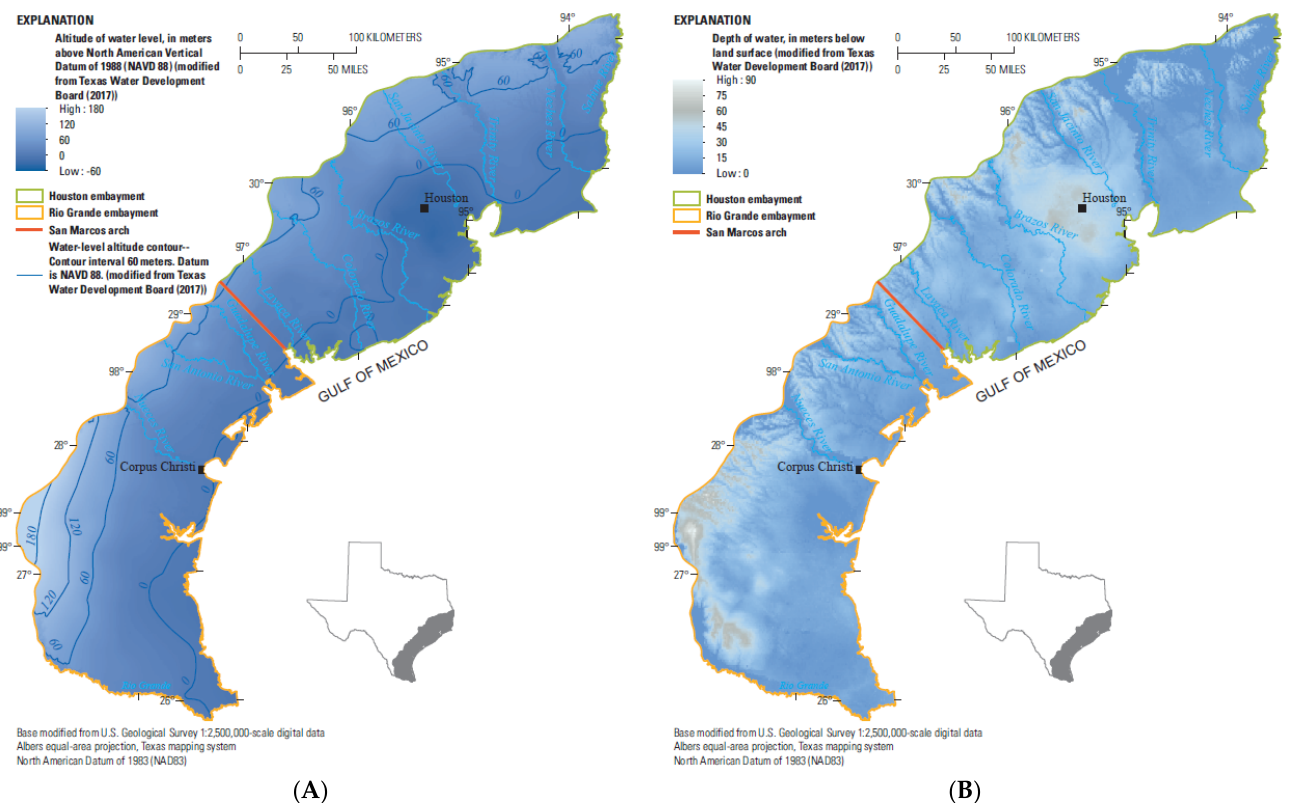
Figure 10. Recent (2007–2016) ( A ) water-level altitudes and ( B ) depth of water (modified from [37]) for permissive tract 3 within the Texas Coastal Plain.